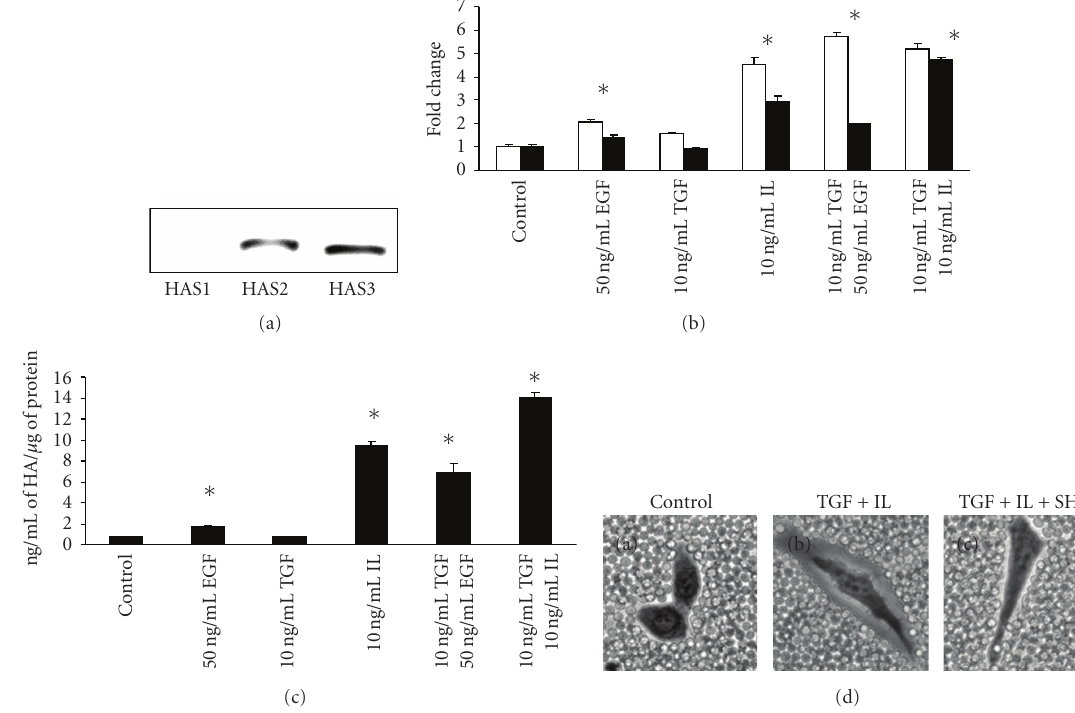
Figure 1: E ff ect of growth factors and cytokines on HA production. (a) Expression of HAS mRNA in A549 cells as visualized by ethidium bromide staining of agarose gel. A549 cells were treated with or without various growth factors and cytokines for 24 hours in RPMI- 1640 supplemented with ITS following overnight serum starvation and assayed for (b) mRNA expression for HAS2 (open bar) and HAS3 (close bar) by quantitative real time RT-PCR, and (c) total HA production using DuoSet HA kit. (d) HA-dependent pericellular matrix was visualized by particle exclusion assay following 24 hours incubation with or without combination treatment with 10 ng/mL each of TGF- β 1 and IL-1 β : Panel (a) , Control; Panel (b) , TGF+IL; Panel (c) , 2 hours incubation with 10units/mL of Streptomyces hyaluronidase following treatment with TGF+IL. The experiments were repeated three times and analyzed in triplicate. Representatives are shown for (b) and (c). (Values are mean ± SD, n = 3, ∗ P < .